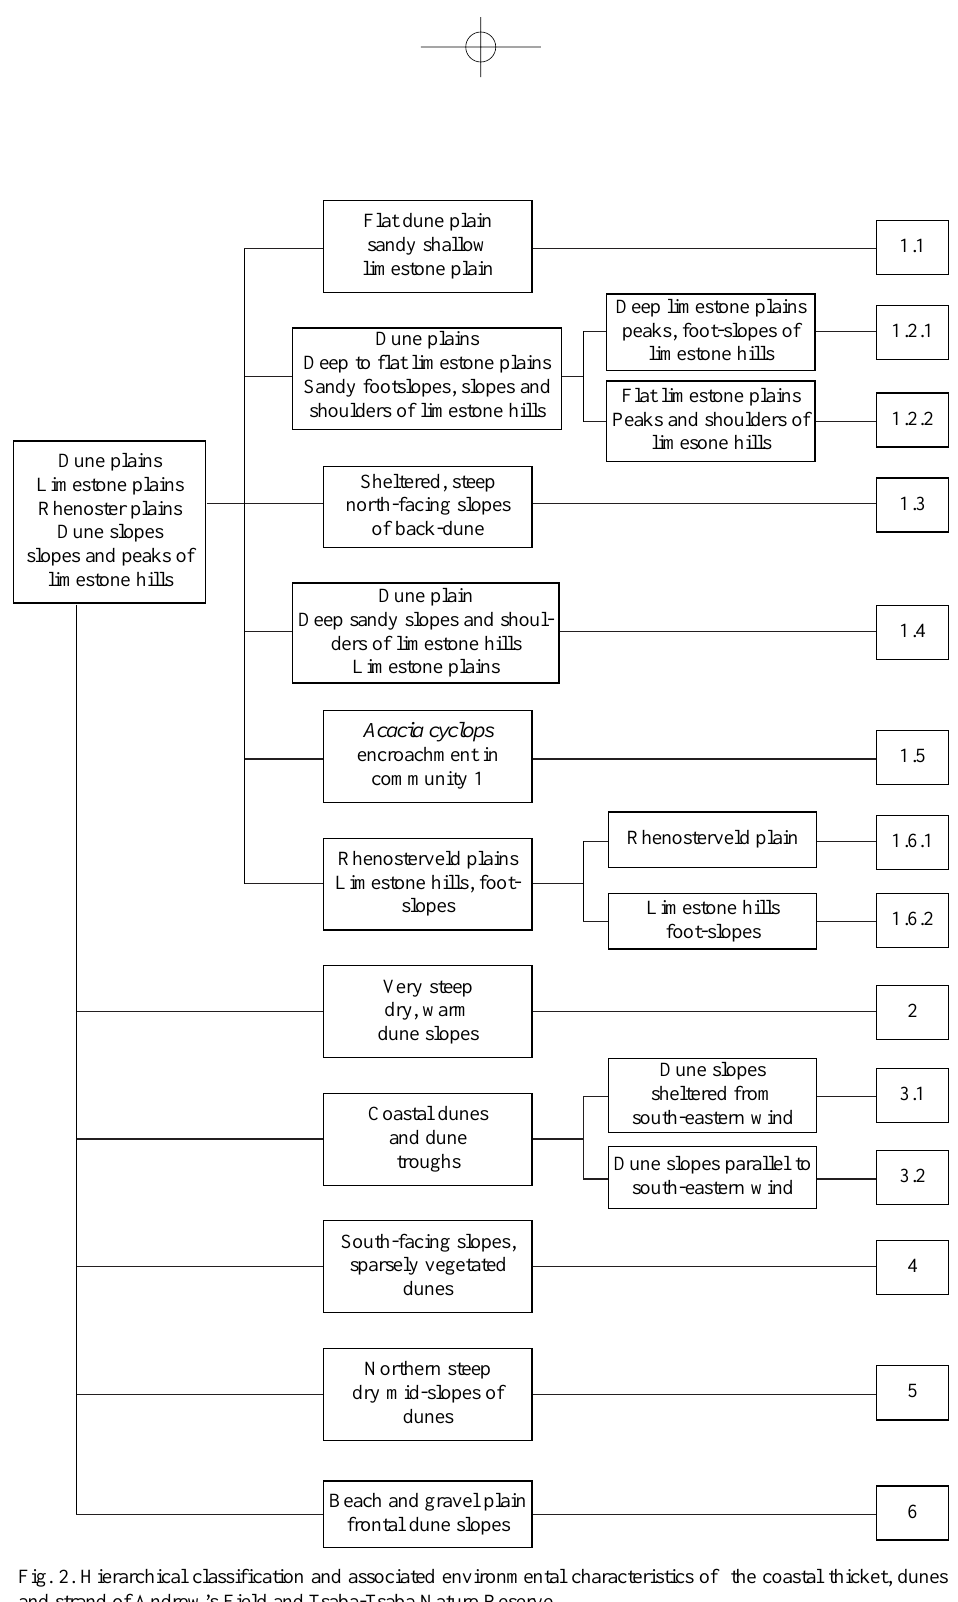
Fig. 2. Hierarchical classification and associated environmental characteristics of the coastal thicket, dunes and strand of Andrew’s Field and Tsaba-Tsaba Nature